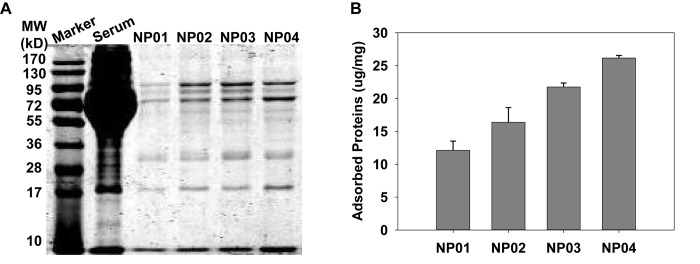
(A) Qualitative characterization of protein corona on nanoparticles using SDS-PAGE. (B) Quantitative analysis of the amounts of adsorbed proteins by BCA assays.